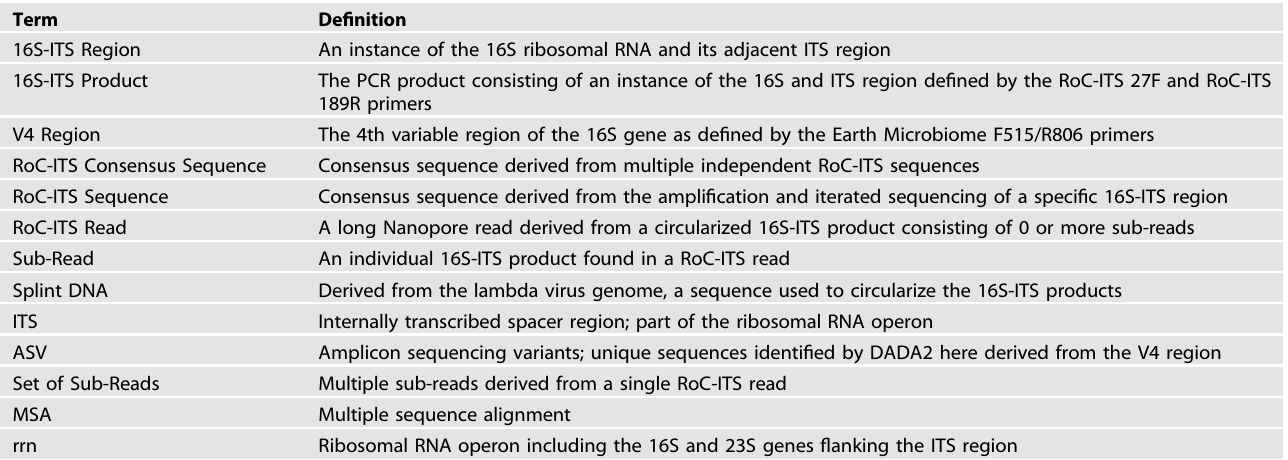
Table 1. De fi nitions of commonly used